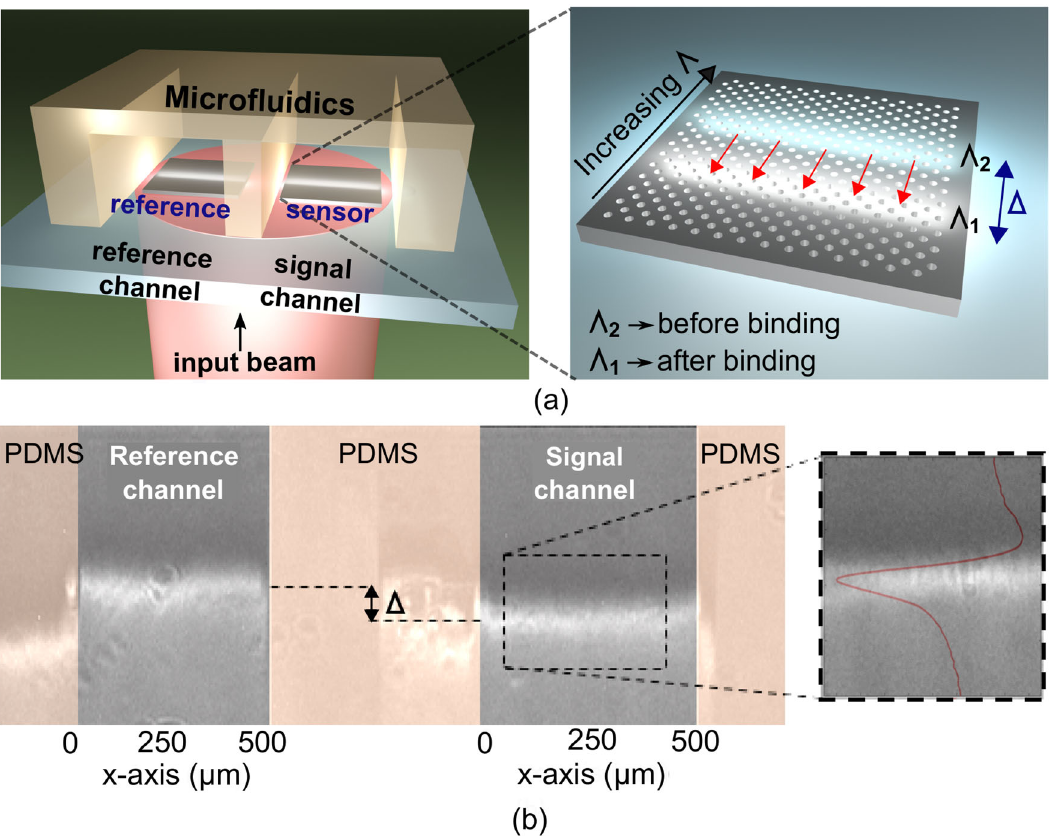
Fig. 3 Nanohole array for biosensing application. a Schematic of the optical system with a nanohole array as sensor and a second micro fl uidic channel included for reference. The inset shows a schematic of the operation principle of a chirped nanohole array with a shift of the resonance position due to a change of the effective index for protein binding. b Camera image of 2 chirped nanohole arrays in the reference and signal channels for an input wavelength of λ = 667 nm. The shift Δ of the resonance position occurs after IgG binding. The inset shows the Fano fi t (red curve) of the resonance